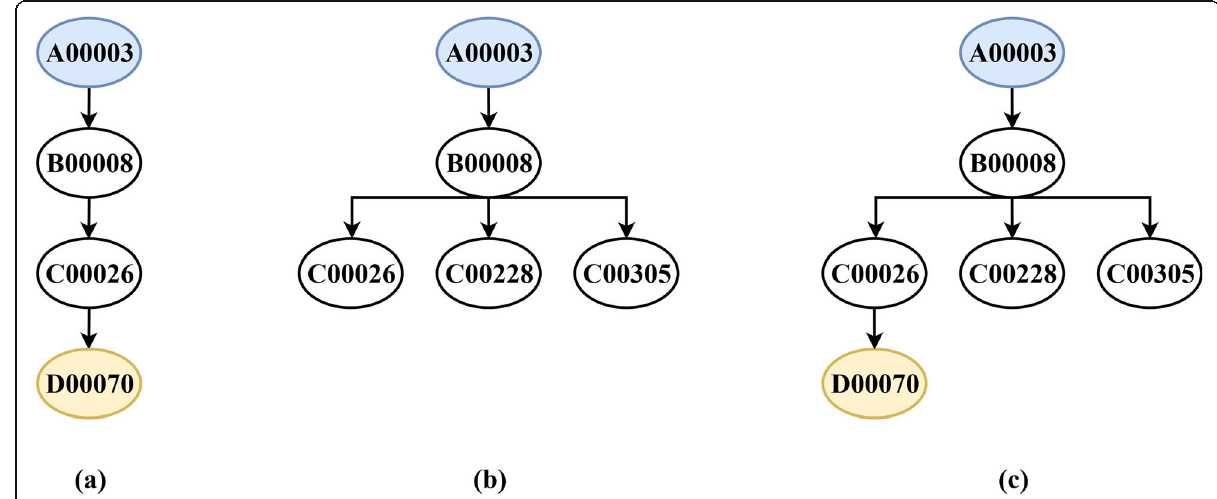
Fig. 4 Identical hierarchy from product log IDs: ( a ) ‘ B00008 ’ is an identical category appears in training ( b ) Parent- and Child-list from identical category ‘ B00008 ’ ( c ) Child categories from identical category ‘ B00008 ’ are embedded to the